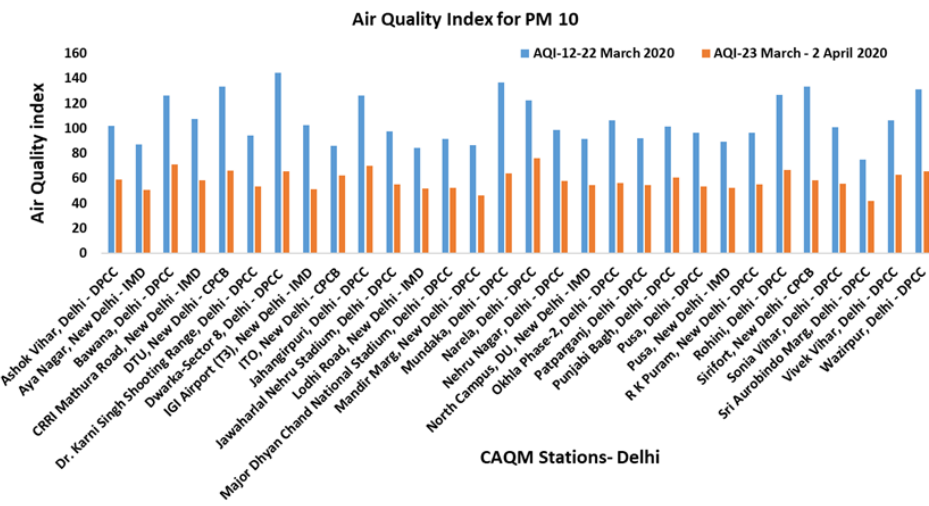
Figure 10. Comparison plot of AQI for PM10 between the pre- and during-lockdown periods. On comparing the district-wise AQI for PM 10 (Table 5), it was found that the maxi- mum reduction of mean AQI was in the case of the Northwest district, i.e., from 121 to 64 (47%). The minimum reduction of mean AQI was found in the West district, i.e., from 101 to 57 (43%). As well, before the lockdown period, the mean AQI was highest in the North district (122) and lowest in the South district (97). During the lockdown period, however, AQI reduced, and the same trend of maximum and minimum mean AQI levels is observed, i.e., the highest for the North district (68) and the lowest for the South district (53). Overall, the mean value of AQI for PM10 showed a net reduction of 46%. Table 5. District-wise comparison of AQI for PM10.